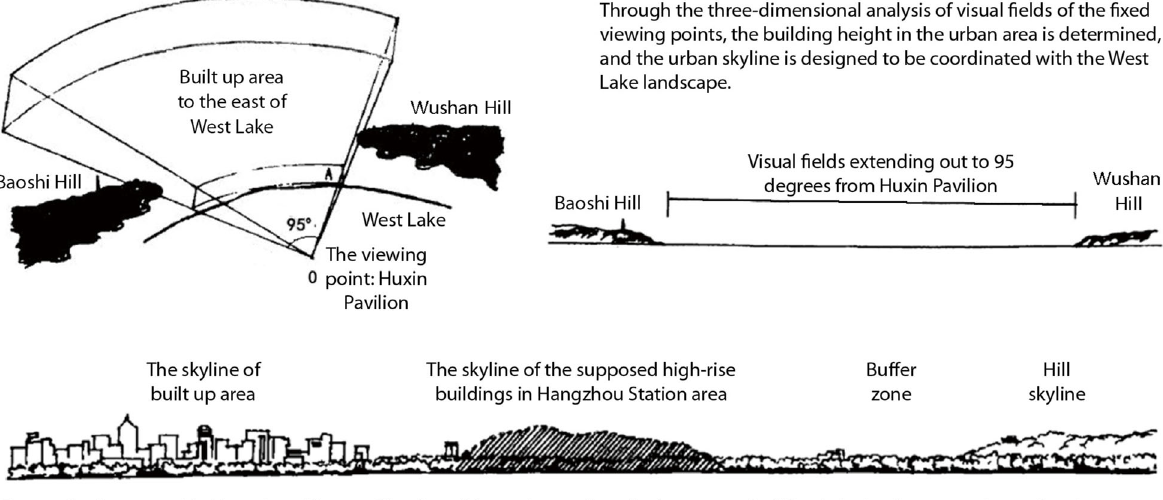
Fig. 6 Visual analysis method applied in Hangzhou Airspace Plan, 1990 (Source: Pan 1994. Modified by the